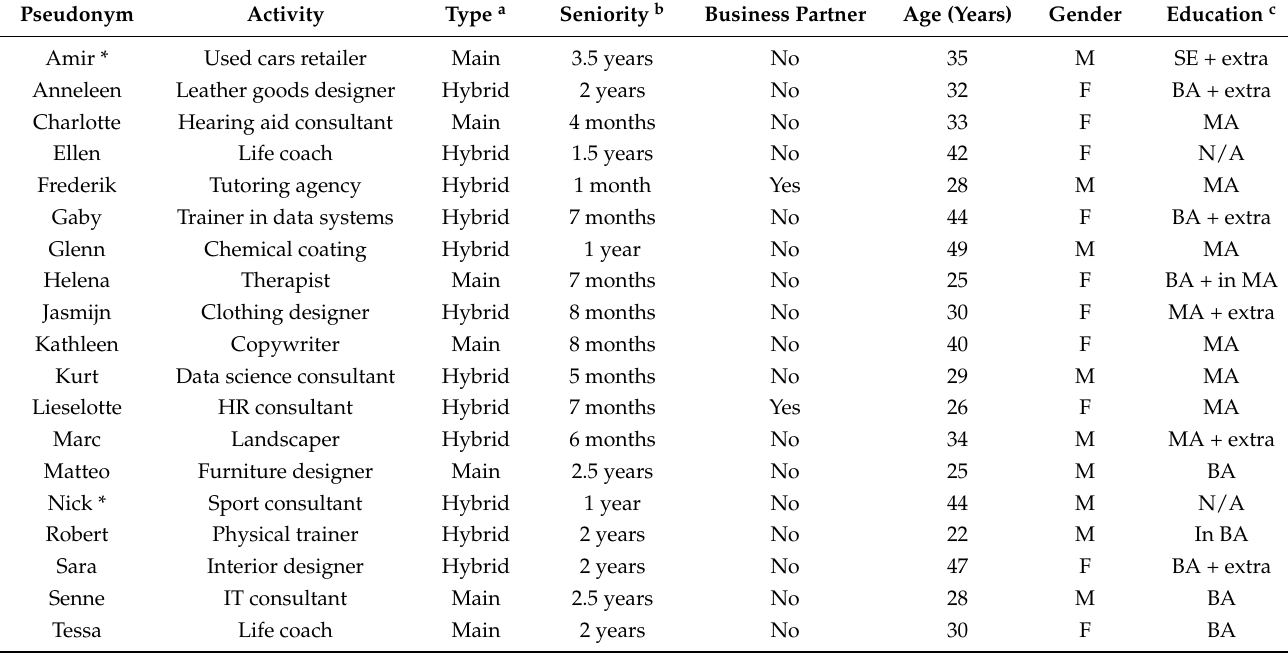
Table 1. Characteristics of the